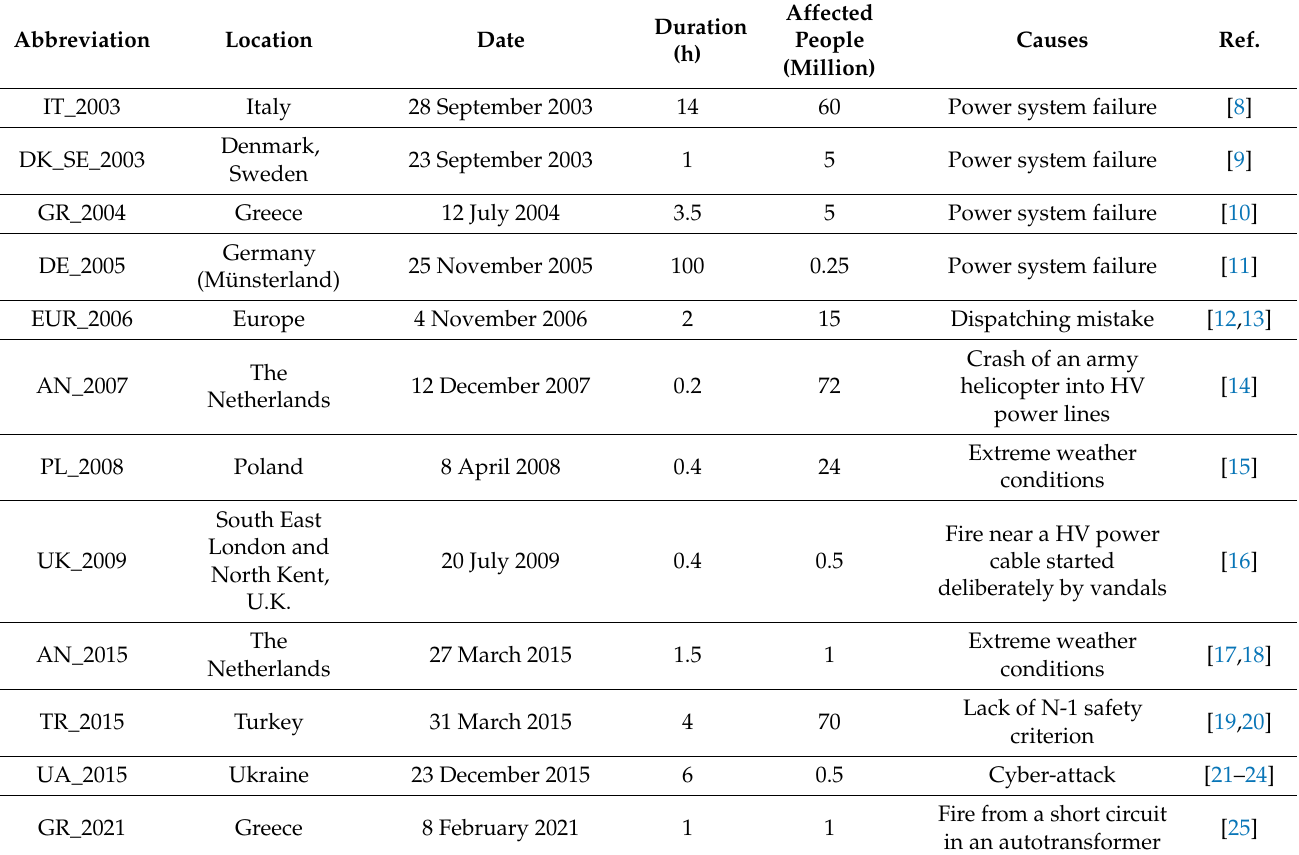
Table 1. Summary of major recorded power outages around Europe in the past 20